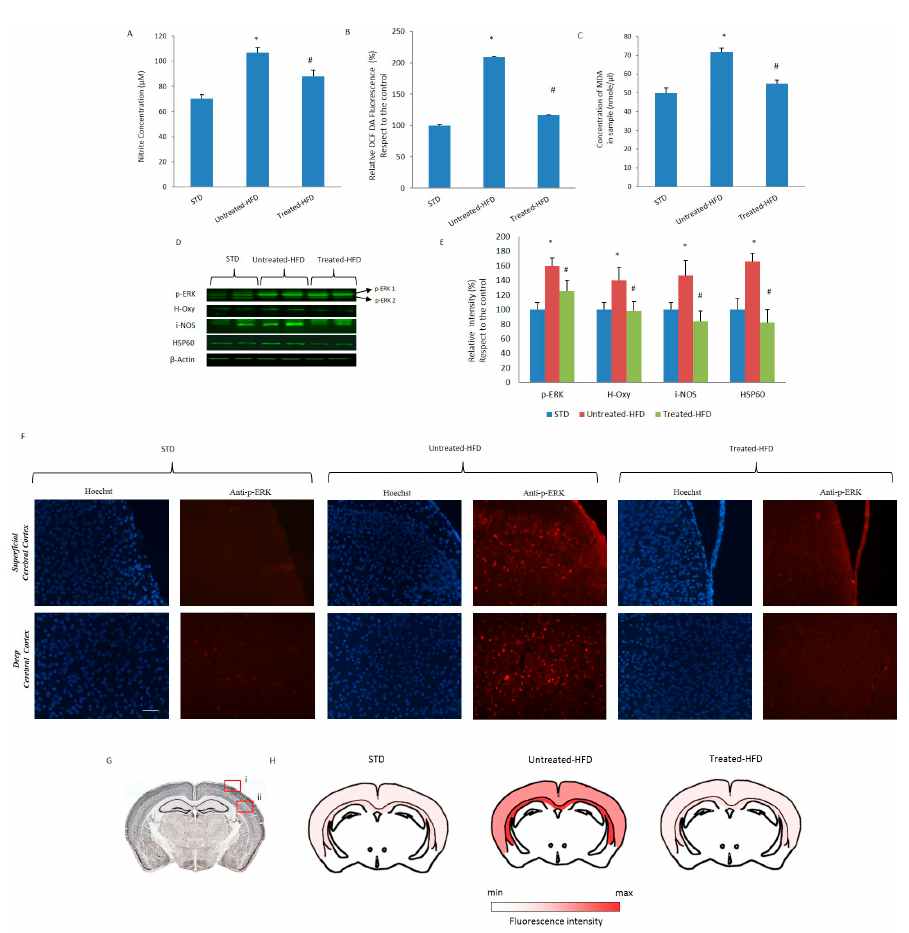
Figure 4. Nitric and oxidative stress and lipid peroxidation in the brains of HFD-mice were prevented by NDS treatment. ( A ) Nitrite concentration in STD, untreated-HFD and treated-HFD brains; ( B ) Levels of ROS in STD, untreated-HFD and treated-HFD brains ( C ) Lipid peroxidation levels in STD, untreated-HFD and treated-HFD brains; ( D ) Western blot of proteins extracted from brains of STD, untreated-HFD and treated-HFD mice and incubated with anti-p-ERK, anti-H-Oxy, anti-i-NOS, anti-HSP60 and anti- β -Actin (loading control); ( E ) Quantification of immunoreactivity was performed using densitometric analysis; ( F ) Immunofluorescence of superficial and deep cerebral cortex sections of STD, untreated-HFD and treated-HFD mice incubated with anti-phospho-ERK; ( G ) Schematic representation of superficial (i) and deep (ii) cerebral cortex positive areas; ( H ) Brain map indicating the levels of positive p-ERK staining. Representative images from 3 animals per group are shown. Bar 20 μ m. Data are the mean values ± SD ( n = 8/group). * p ≤ 0.05 vs. STD. # p ≤ 0.05 vs. untreated-HFD.